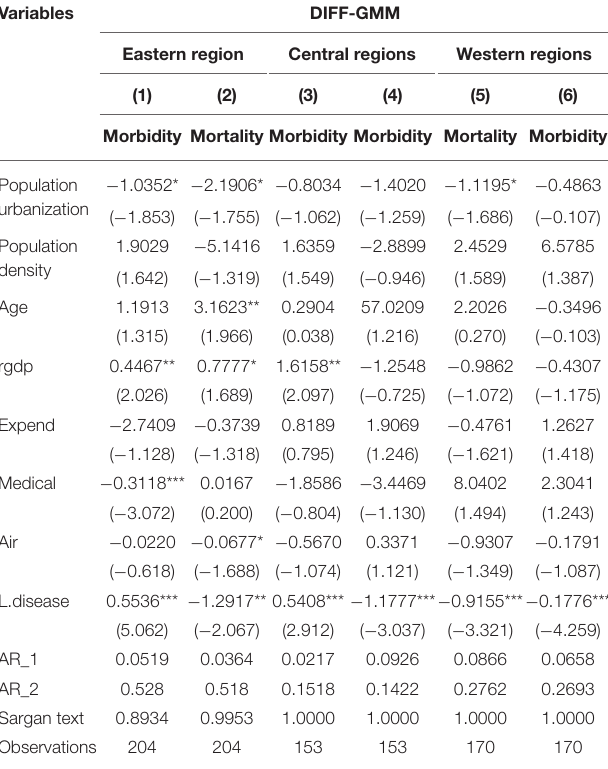
TABLE 5 | The robustness test of population urbanization. Variables